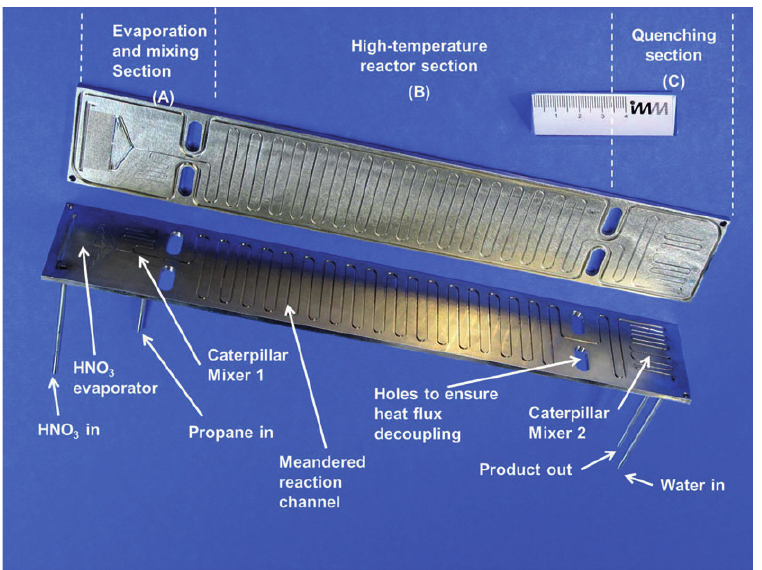
Figure 3 Structured reactor plates prior to welding. Channels were made by micromilling; the caterpillar-type mixers (mixer 1: CPMM 300; mixer 2: CPMM 600; IMM) were fabricated by laser